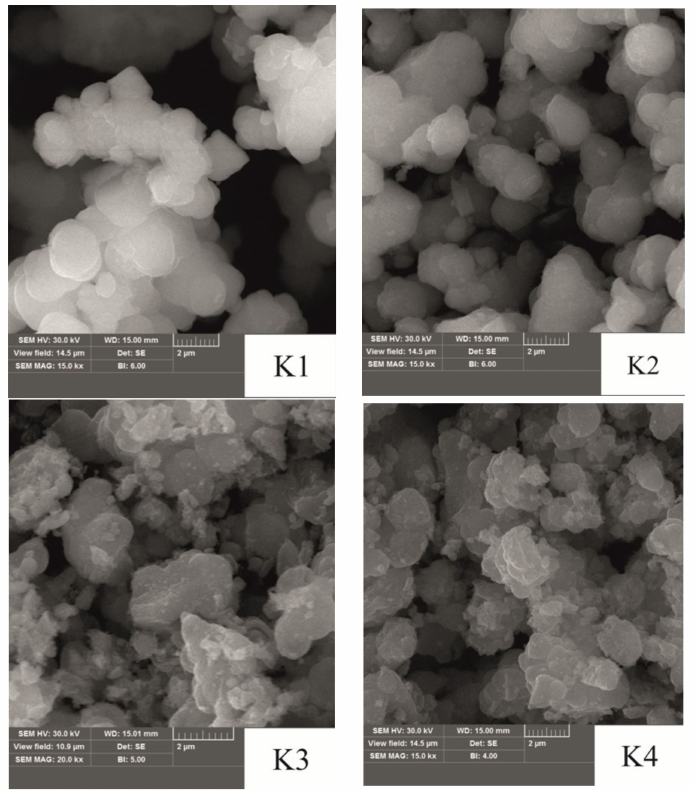
Figure 3. SEM images for the synthesized initial material K1 and obtained at annealing temperatures of 150 (K2), 250 (K3), and 350 ◦ C